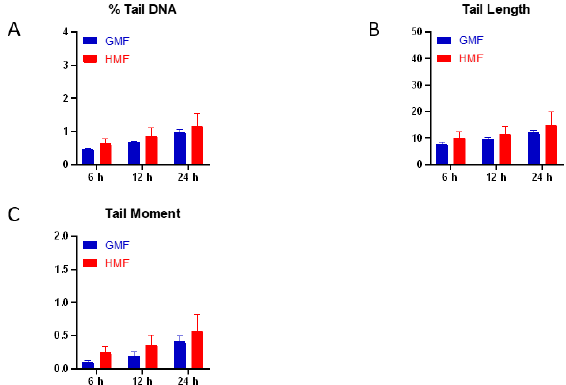
Figure 1. Comet assay results of cells exposed to HMF. The percentage of DNA in tail ( A ), tail length ( B ) and tail moment ( C ) are shown in the panel correspondingly. The results of triplicate samples of three independent experiments are reported together with the SEM for each time-point. Cells in exponential phase of growth were cultured in HMF for 6, 12 and 24 h.